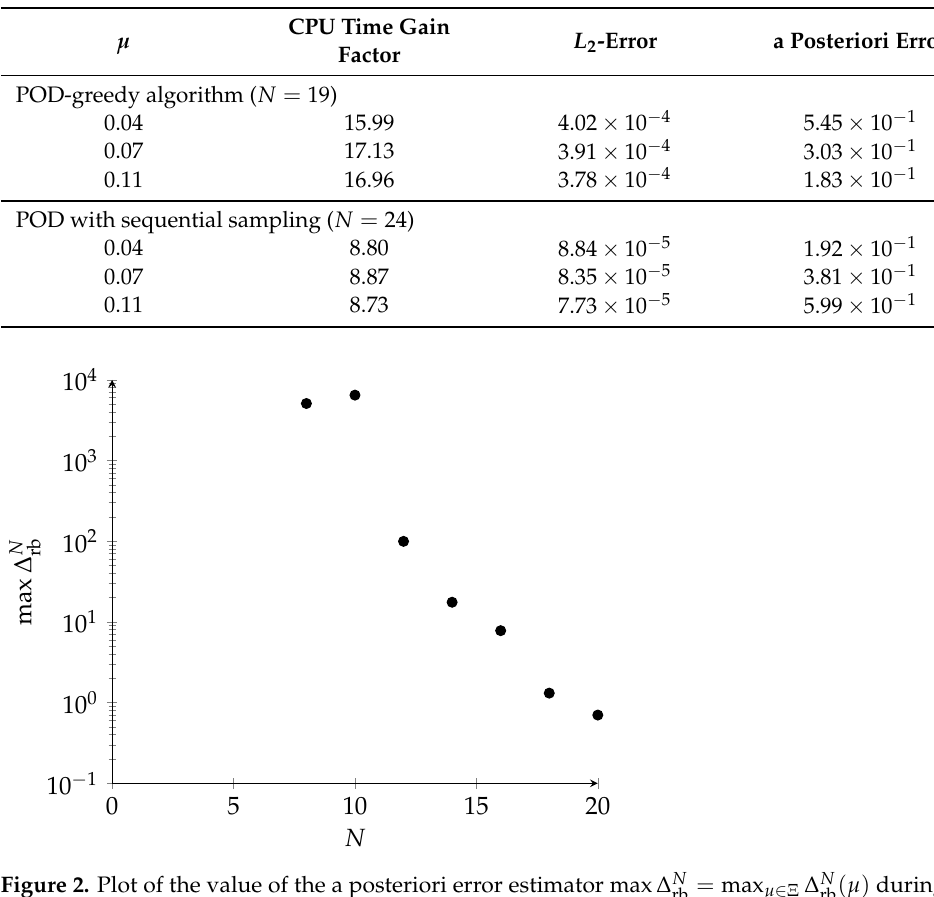
Figure 2. Plot of the value of the a posteriori error estimator max ∆ N offline stage computed by the POD-greedy algorithm. Dimension of resulting reduced basis is N = 20 for ε tol = 1 (Experiment